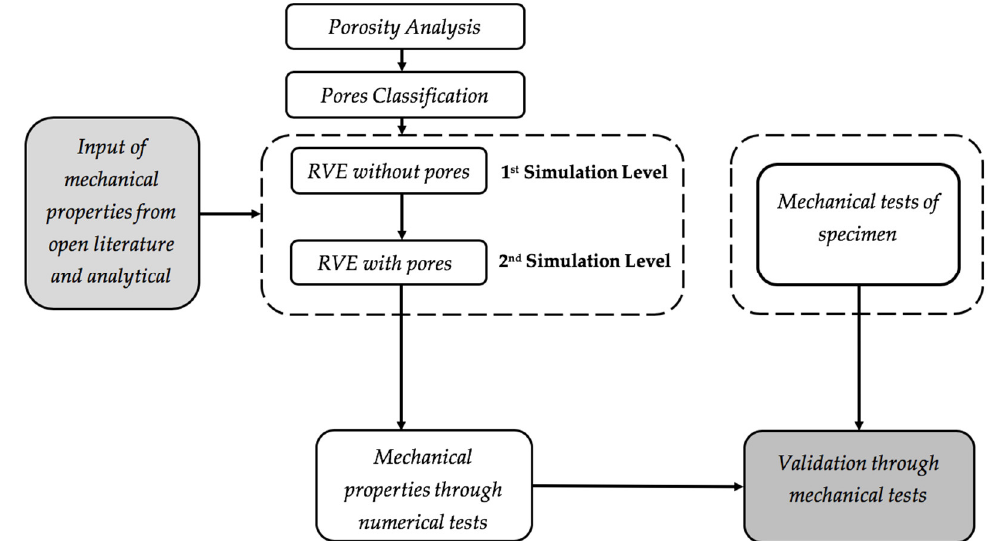
Figure 1. Flowchart of the methodology.